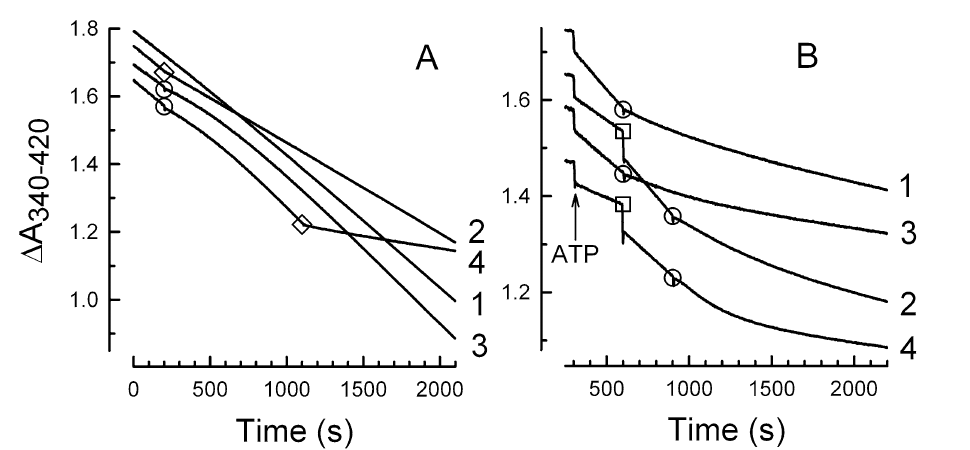
Figure 5. The ventA-induced increase in ATPase activity is inhibited by adding excess ε subunit. Panel ( A ): ATPase was assayed as described in “Methods” using 1.47 µg of WT membrane protein in the presence of 38.5 mM selenite. Symbols indicate addition of 67 nM ε (◊) or 9.5 μM ventA ( ○ ). Early rate (U/mg, first 3 min of assay): 2.30 (SD, ± 0.13 for traces 1–4). Late rates (U/mg, last 3 min of assay): #1 , 2.2 (± 0.3, n = 3); #2 , 1.4 (± 0.2, n = 3); #3 , 2.7 (± 0.3, n = 3), #4 , 0.28 (± 0.05, n = 3). For trace #4 , during 100 s immediately before adding ε, the rate is 2.5 (± 0.4, n = 3) U/mg. Panel ( B ): traces representative of 2 experiments in which membranes were first added to the assay medium (see “Methods”) but lacking ATP and containing 88 nM ε. Membranes were either WT (traces: #1, 4.2 μg; #2, 2.1 μg), or ε88-stop (traces: #3, 3.1 μg; #4, 1.24 μg). Arrow indicates addition of 1 mM ATP to initiate each assay. Symbols indicate addition of 38.5 mM selenite ( □ ) or 10 μM ventA ( ○